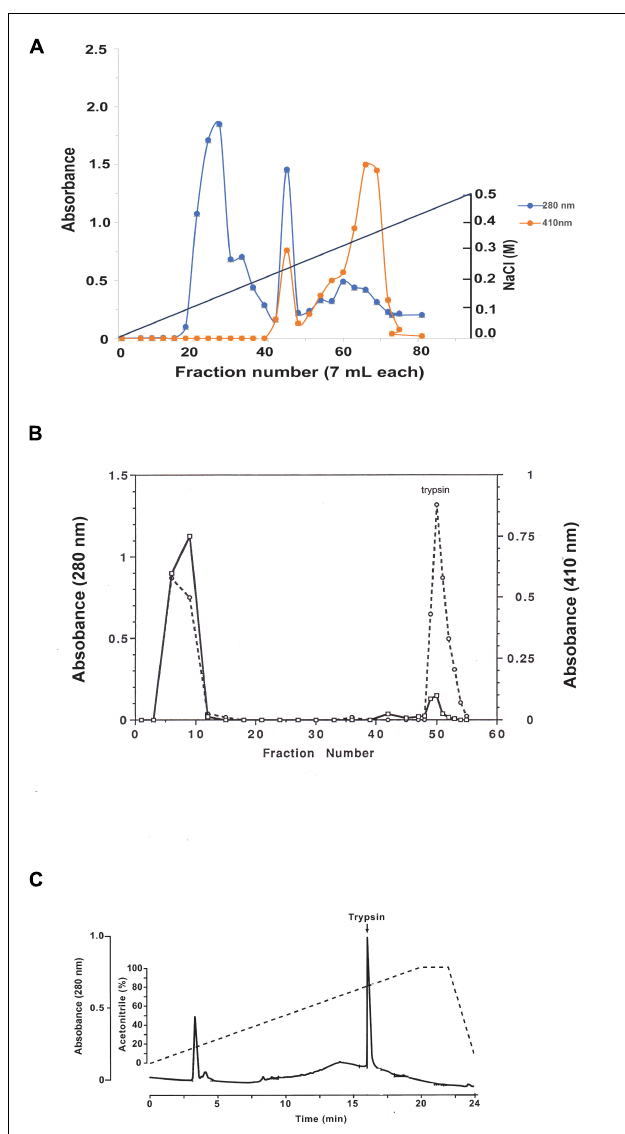
FIGURE 2 | Purification of C. quinquefasciatus late trypsin using column chromatography. (A) Purification using DEAE chromatography. Protein absorbance at 280 nm is shown in the blue line. Trypsin activity was followed using BApNA monitored at 410 nm (orange line). NaCl elution gradient is shown as a black line. (B) Affinity chromatography of C. quinquefasciatus late trypsin on Soybean trypsin inhibitor Sepharose-4B column. Late trypsin was eluted with 20 mM Glycine-HCl pH 3.0 buffer. Protein was followed by absorbance at 280 nm (solid black line) and trypsin activity was followed using BApNA at 410 nm (broken line). (C) Reverse phase C 18 HPLC. Protein was eluted using a linear gradient of acetonitrile in the presence of.1% TFA (dashed line). The column was calibrated with [1,3- 3 H]DIP trypsin (arrow). Collected fractions were monitored for protein at 280 nm (solid line) the late trypsin was found to elute at 16.04